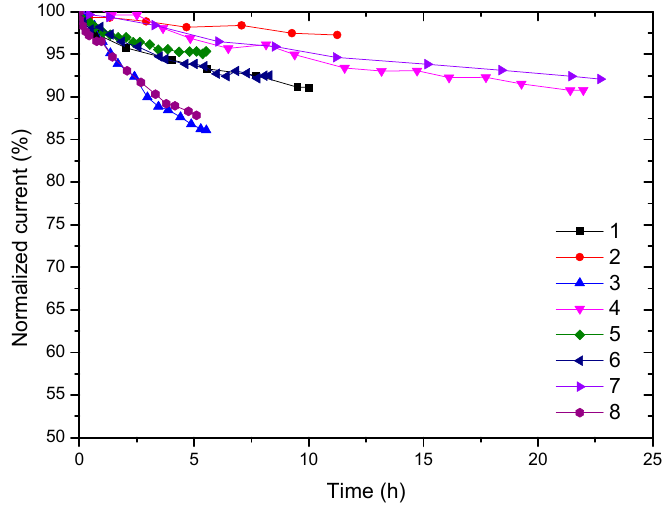
Figure 4. Long-term stability curves of hybrid materials: (1) Co 0.03 @CoO-N-doped graphene Figure 4. Long ‐ term stability curves of hybrid materials: (1) Co 0.03 @CoO ‐ N ‐ doped graphene carbon carbon shells-800 (at − 0.4 V vs. SCE) [47]; (2) Two-dimensional materials based on ternary system shells ‐ 800 (at − 0.4 V vs SCE) [47]; (2)Two ‐ dimensional materials based on ternary system of B, C and of B, C and N (B(2 at%)N(5 at%)G-1000 ◦ C) [48]; (3) N/Co-doped PCP//NRGO (at − 0.25 V N (B(2 at%)N(5 at%)G ‐ 1000 °C) [48]; (3) N/Co ‐ doped PCP//NRGO (at − 0.25 V vs Ag/AgCl) [53]; (4) vs. Ag/AgCl) [53]; (4) CoCN@CoO x (18)/NG (cobalt carbonitride/nitrogen doped graphene) [54]; CoCN@CoO x (18)/NG (cobalt carbonitride/nitrogen doped graphene) [54]; (5) Co 3 O 4 /NG(nitrogen ‐ (5) Co 3 O 4 /NG (nitrogen-doped graphene) (at − 0.36 V vs. SCE) [57]; (6) CoNPs@NG (nitrogen-doped doped graphene) (at − 0.36 V vs SCE) [57]; (6) CoNPs@NG (nitrogen ‐ doped graphene) [58]; (7) graphene) [58]; (7) C(PANI)/Mn 2 O 3 (hybrid) (at 0.8 V vs. RHE) [59]; and (8) CoO/MnO 2 /RGO C(PANI)/Mn 2 O 3 (hybrid) (at 0.8 V vs RHE) [59]; and (8) CoO/MnO 2 /RGO (reduced graphene oxide) (reduced graphene oxide) (at 0.66 V vs. RHE) (at 0.66 V vs RHE) [60].